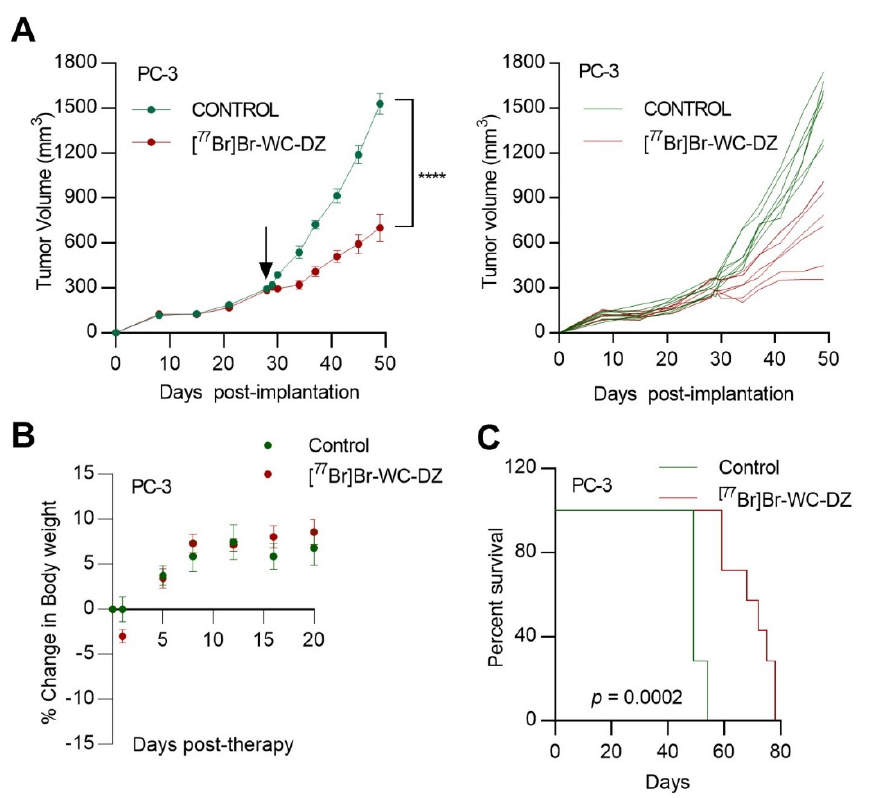
Figure 5. The [ 77 Br]Br-WC-DZ-inhibited tumor growth in animal models of prostate cancer. ( A ), mean tumor volume ( ± SEM) in athymic nude mice (n = 7) after treatment (indicated by black arrow) with 56 MBq of [ 77 Br]Br-WC-DZ. Control group received saline. Individual tumor-growth curves for control and [ 77 Br]Br-WC-DZ-treated groups are also shown. ( B ), the plots showing the average percent change in body weight of mice treated with control or [ 77 Br]Br-WC-DZ. ( C ), Kaplan–Meier survival study of PC-3-tumor-implanted mice showed improved survival of [ 77 Br]Br-WC-DZ- treated mice. Statistical significance was determined using a Mantel–Cox log-rank test. **** p < 0.0001.